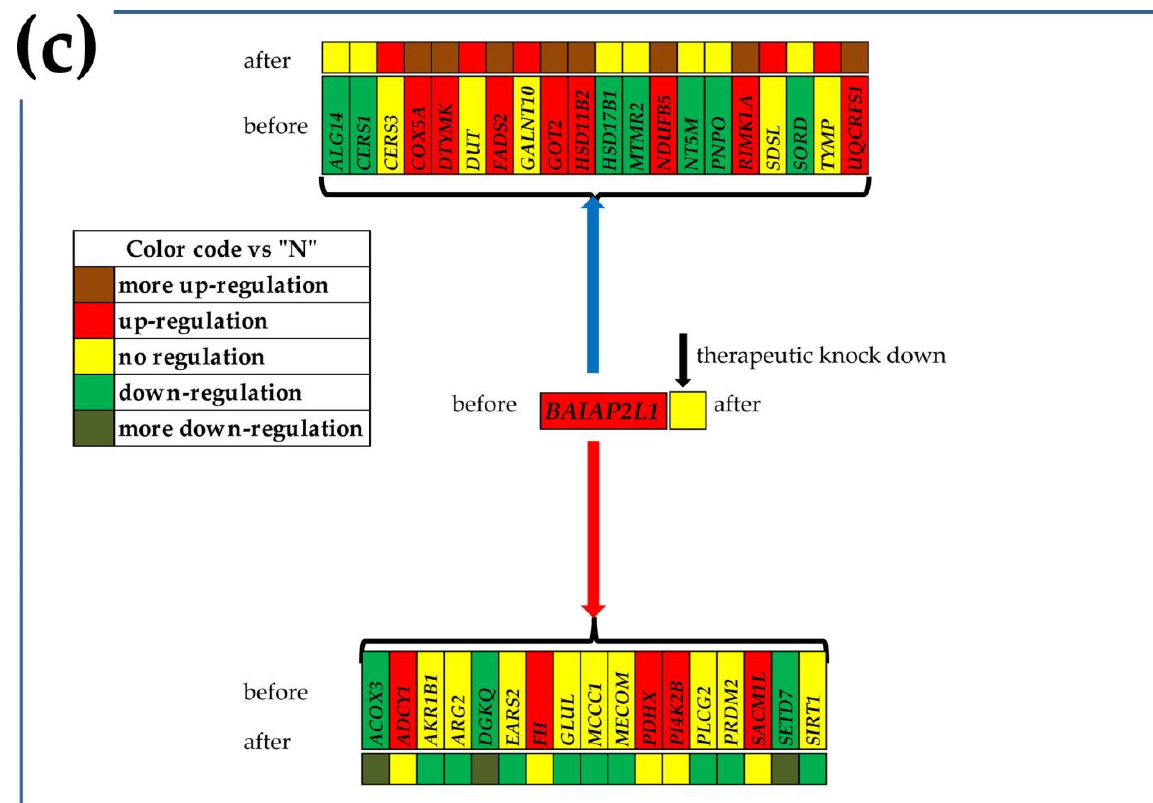
Figure 6. Significantly synergistically and antagonistically expressed metabolic genes with the corresponding GMR in the nodules ( a ) “A”, ( b ) “B” and ( c ) “C” of the “ABCN” patient and the predicted regulations after the therapeutic alteration of the GMR. The red/blue arrow indicates the genes synergistically/antagonistically expressed with the GMR in that nodule. Gene symbol background indicates the status of that gene in the mentioned cancer nodule with respect to the surrounding normal tissue “N”.